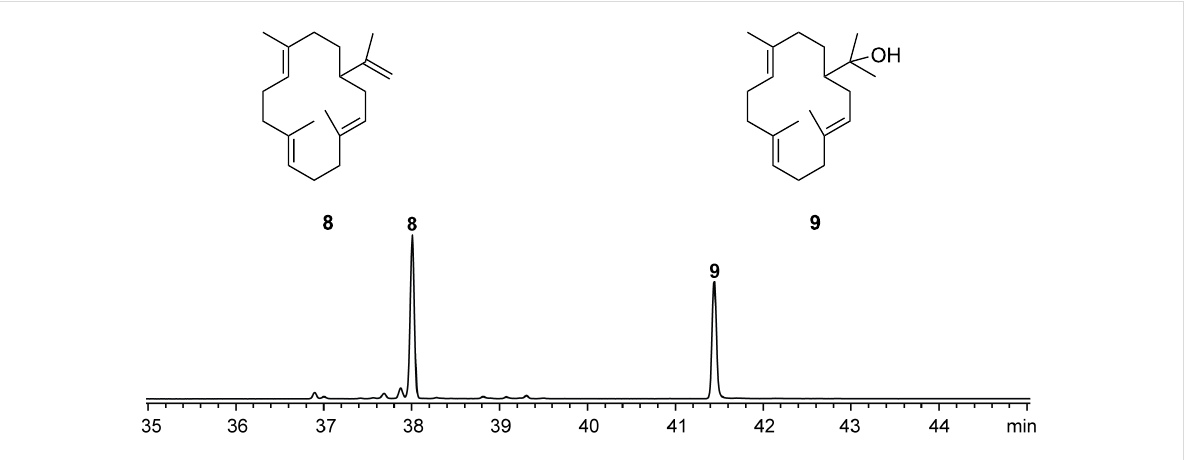
Figure 5: Total ion chromatogram of an extract from an incubation of GGPP with the SmTS1 A222V variant.